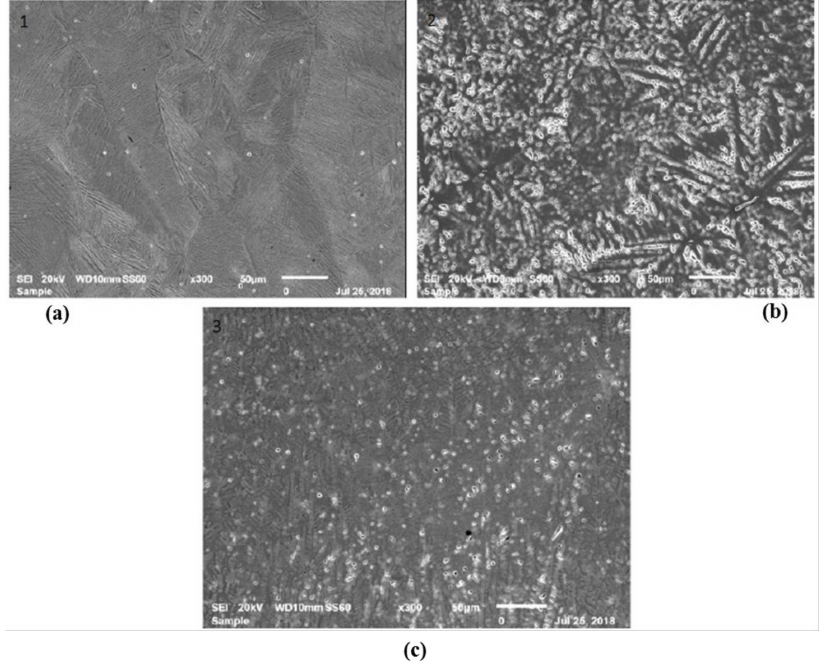
Figure 3. High-magnification SEM images of the as-built samples: sample 1 ( a ); sample 2 ( b ); and sample 3 ( c ) prior to heat treatment.